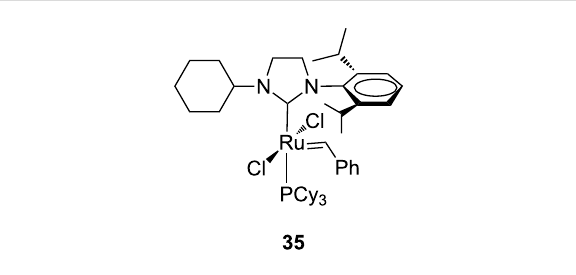
Figure 9: Grubbs-type complex 35 with an N- cyclohexyl, N’ -2,6-diiso- propylphenyl NHC. Studies on this class of unsymmetrical NHC ligands were also extended to the Hoveyda-type complexes 36 – 40 (Figure 10) [24]. The effect of the modified NHC ligand was investigated in model metathesis reactions (RCM of 7 , ROMP of 16 and CM of 13 with acrylonitrile) in comparison to complex 24b and the parent complexes GII-SIMes and GII-SIPr .